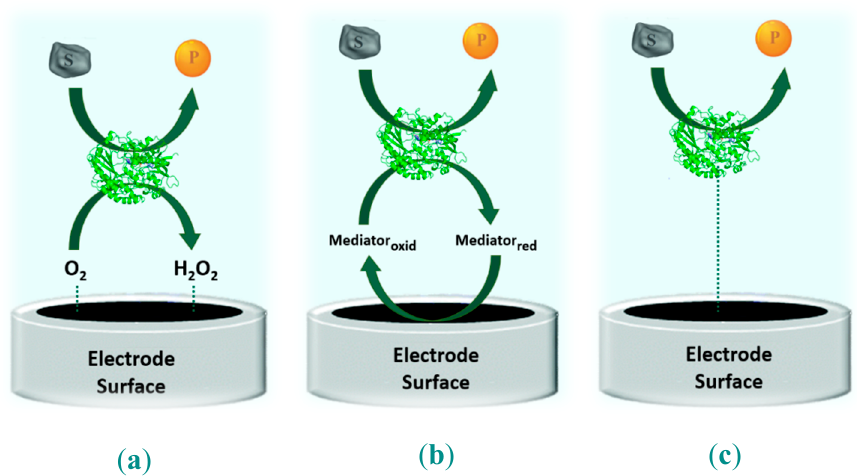
Figure 4. Schematic illustration of ( a ) First-generation amperometric glucose biosensor, with the electrons resulting from β -D-glucose substrate (S) enzymatic (GOx) reaction reducing the molecular O 2 into H 2 O 2 as produces the gluconolactone (P). ( b ) Second-generation amperometric glucose biosensor, where the electrons resulting from β -D-glucose oxidation reaction (S to P) are transferred to a mediator molecule that transports them from GOx enzyme active site to the electrode surface. ( c ) Third-generation amperometric glucose biosensor, where the electrons resulting from β -D-glucose oxidation are directly transferred from the redox-active site of enzyme cofactor (GOx) to the electrode surface previously modified. Adapted from [54] .